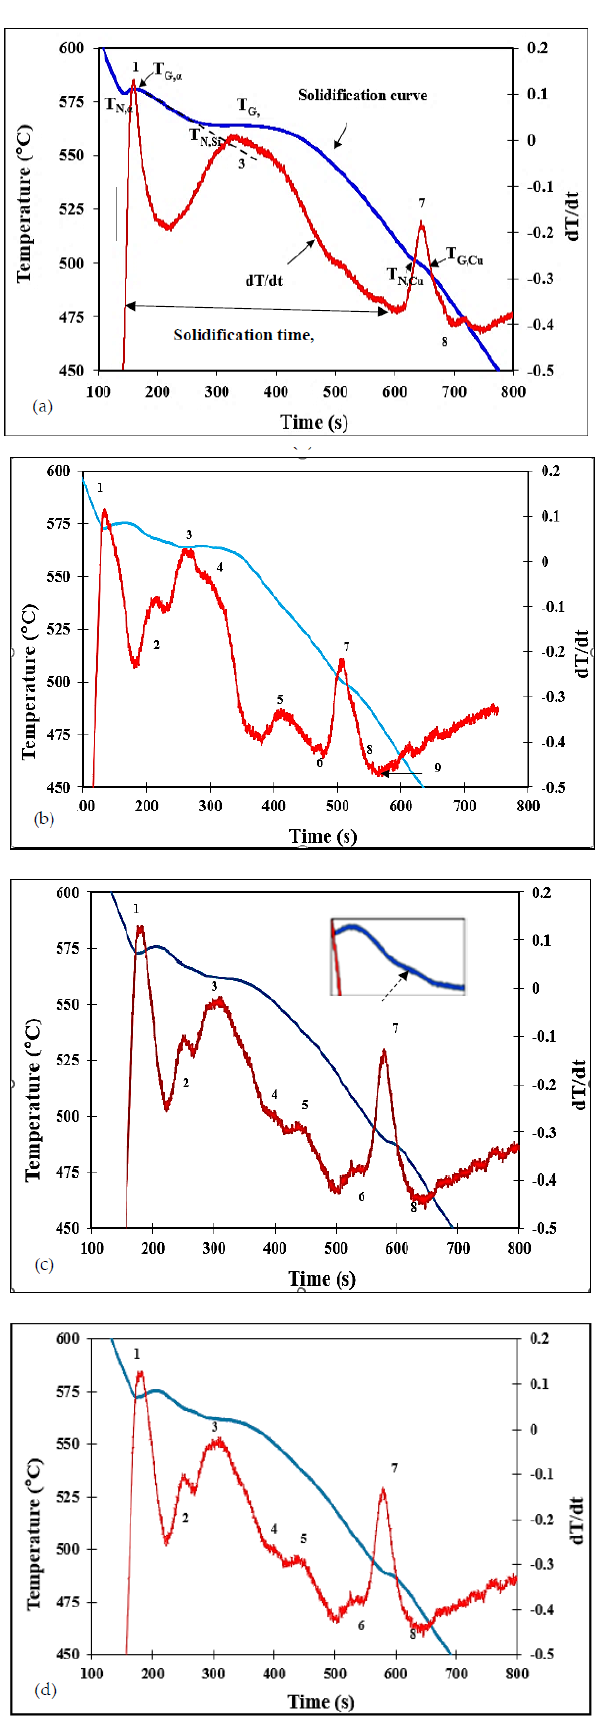
Figure 5. Solidification curves and their first derivatives from samples solidified at the rate of ~0.35 C/s: ( a ) experimental alloy, ( b ) alloy A, ( c ) alloy B, and ( d ) alloy